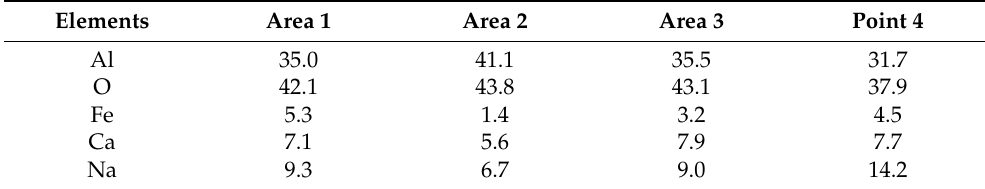
Table 6. EDS elemental analysis of different areas and points of Figure 11a.